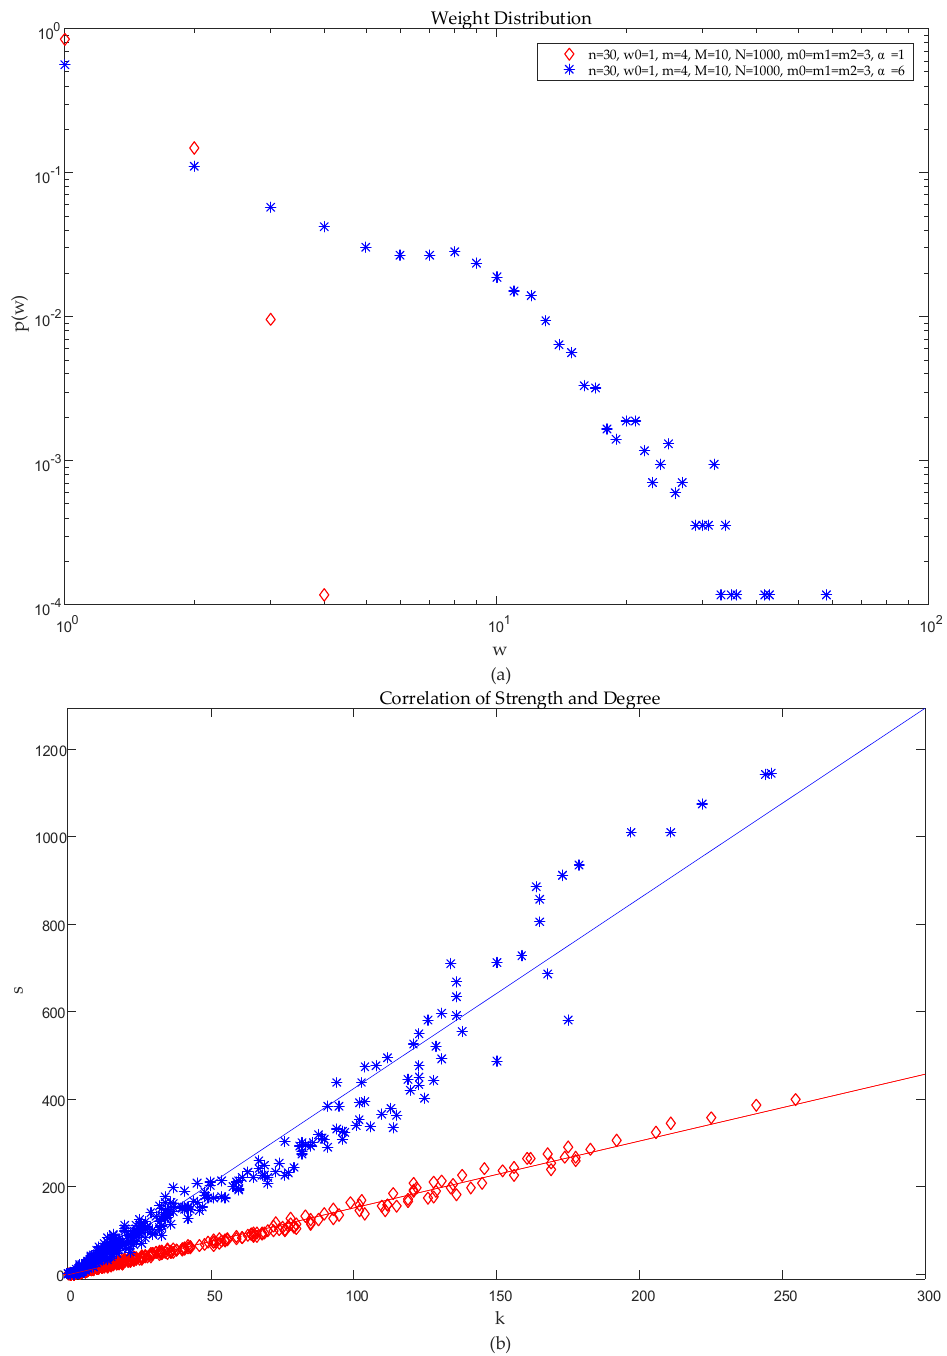
Figure 9. Analysis of the influence of extra traffic load (cid:2009) on network structure performance: ( a ) Distribution of edge weights; ( b ) Distribution of the correlation of strength and Degree.